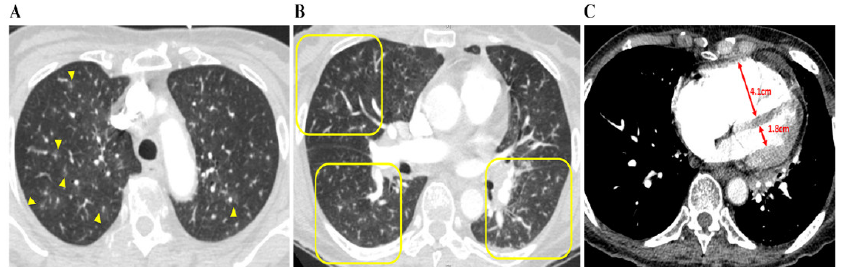
Figure 2. Chest CT findings concerning patients with PTTM. A 73-year-old woman with advanced gastric cancer (Case 8). ( A ) Bilateral lung CT scan results showing disseminated centrilobular GGNs (yellow arrows), ( B ) in which occasional vascular trees-in-bud signs (yellow squares) are noted. ( C ) Right and left ventricle (RV and LV) diameters are 4.1 cm and 1.8 cm, respectively, and the RV: LV ratio is 2:3, indicating that RV dysfunction, despite pulmonary arterial thromboembolism is not being depicted. Abbreviations: CT, computed tomography; GGNs, ground-glass nodules; LV, left ventricle; PTTM, pulmonary tumor thrombotic microangiopathy; RV, right